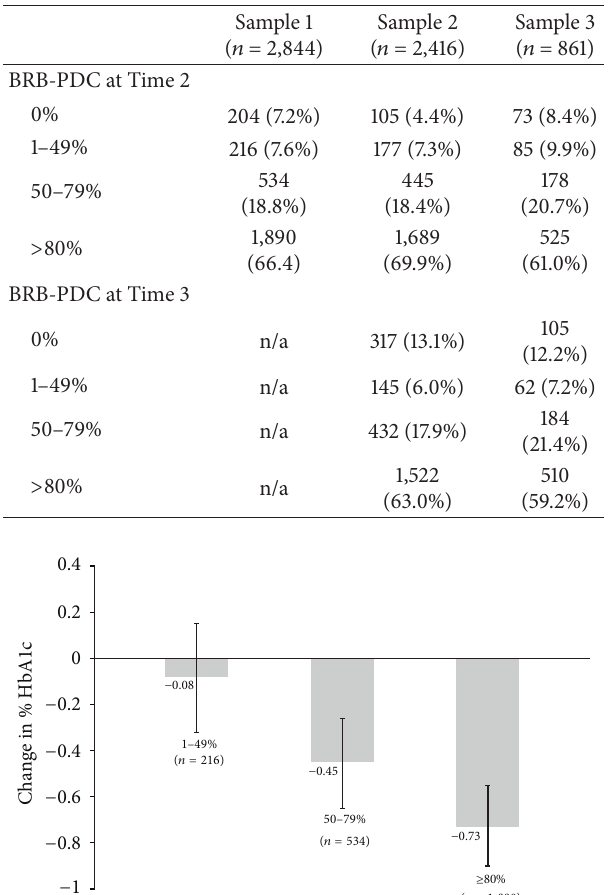
Table 2: Distribution of Biologic Response Based Proportion of Days Covered (BRB-PDC) at Time 2 and Time 3 for each of the relevant study samples. Data are number (%) of patients.